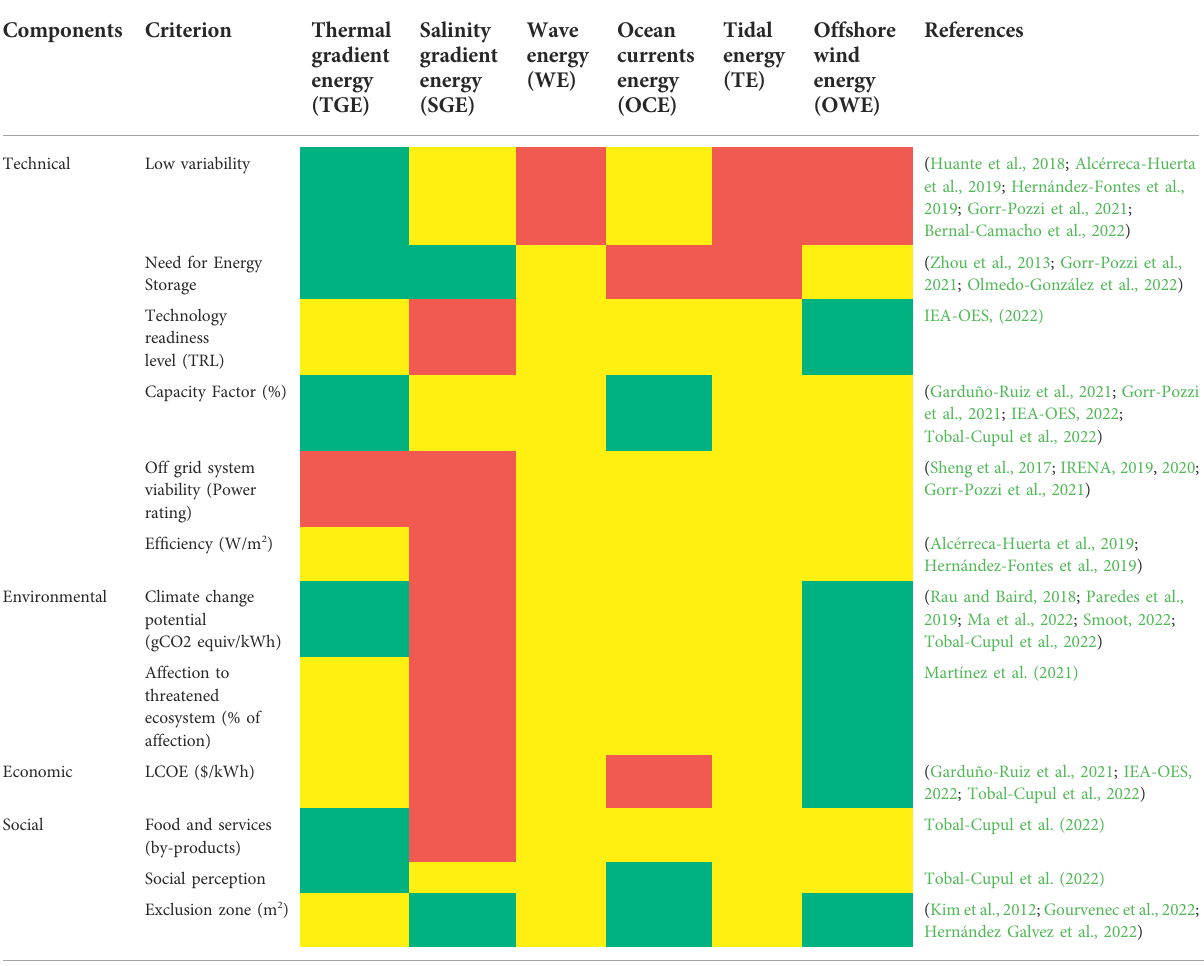
TABLE 1 Criteria to foster the sustainable deployment of MREs in Mexico ’ s coastal